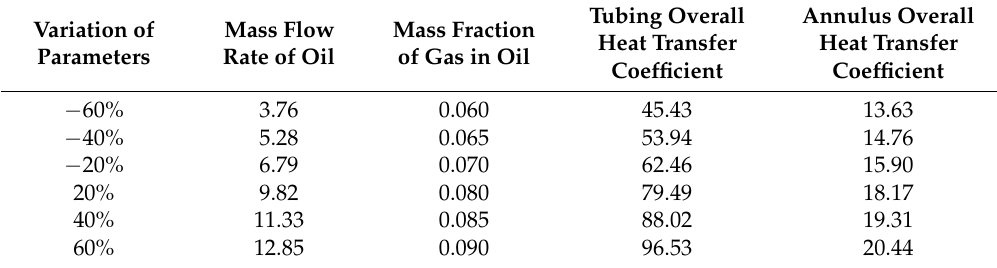
Table 2. Values of Sensitized Parameters .